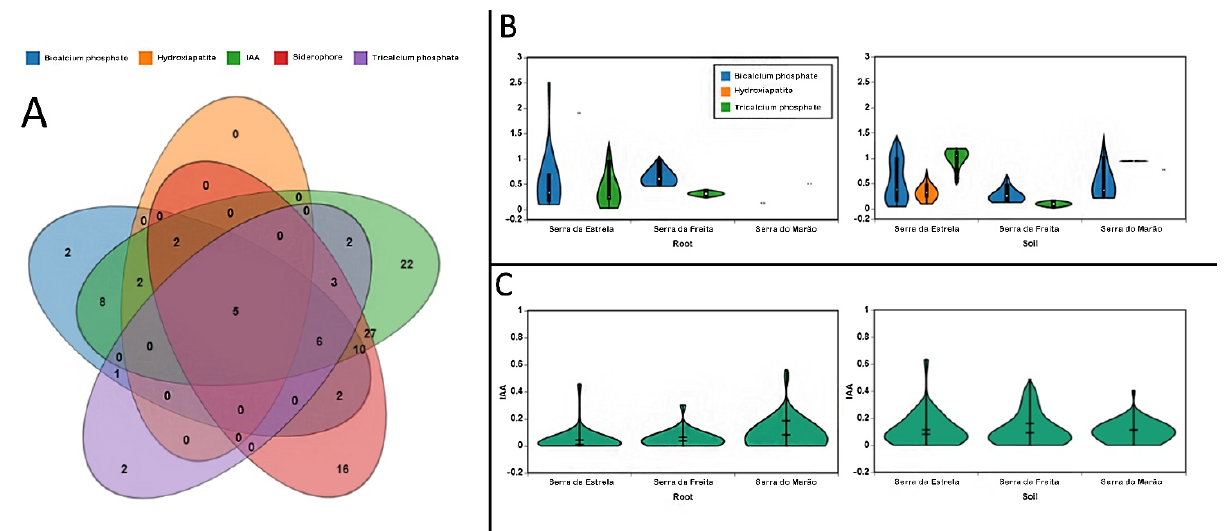
Figure 5. PGP mechanisms of the isolated and nonpathogenic strains. ( A ) Venn diagram of the PGP mechanisms of studied strains, ( B ) phosphate solubilization, and ( C ) IAA production.